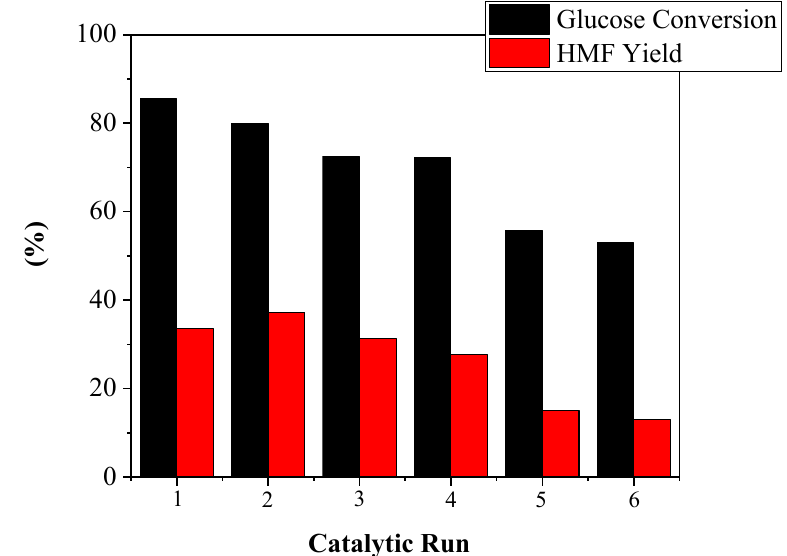
Figure 10. Reutilization study for Al 7 Zr 3 catalyst (150 ◦ C, 60 min, glucose / catalyst weight ratio of 3 and 0.65 g CaCl2 · g aq.sol. − 1 ).